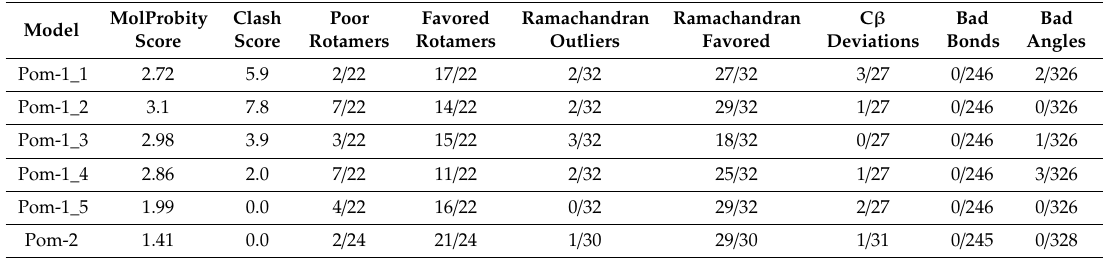
Table 1. Structure evaluation of the six predicted models for Pom-1 and